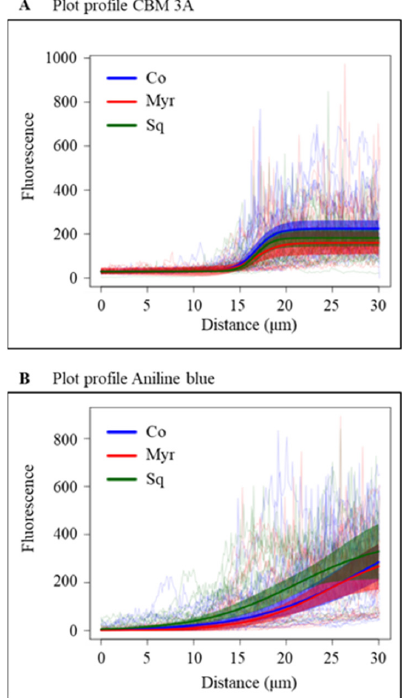
Figure 9. Analysis of GFP-CBM3A and Aniline Blue fluorescence distribution along pollen tubes. Each line represents the mean of grey values measured in previously analyzed pollen tubes (n > 10).